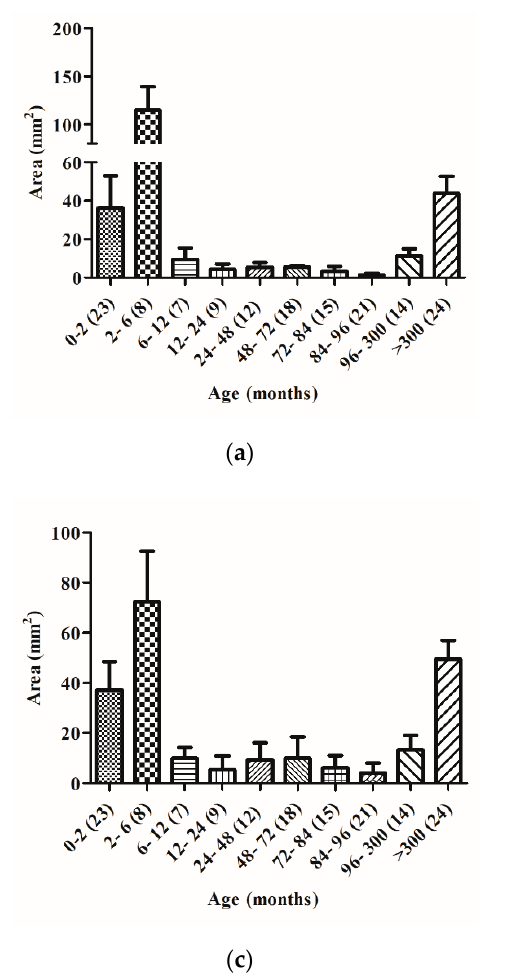
Figure 5. Gliadinase activity of fecal expected carboxypeptidase A1 (CBPA1), elastase 2A (CEL2A), and elastase 3B (CEL3B) from samples from different age range volunteers. Degradative gliadin activity was evaluated by zymography and quantified by densitometry of the corresponding hydrolytic areas: > 97 kDa for expected CBPA1 (a), 45–35 kDa for expected CEL2A (b), and 30–25 kDa for expected CEL3B (c). The results are grouped by age ranges of samples. Brackets reflect the number of volunteers of each age group. Interaction of age with gliadinase activity is shown by two way ANOVA. ( a ) p = 0.2128; ( b ) p = 0.0905; ( c ) p = 0.0001.